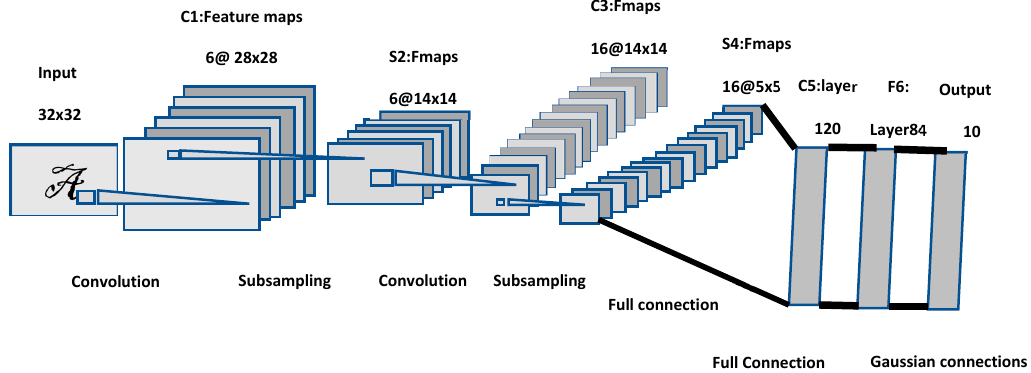
Figure 2. Architecture (our own redrawing) of the LeNet-5 model [27].